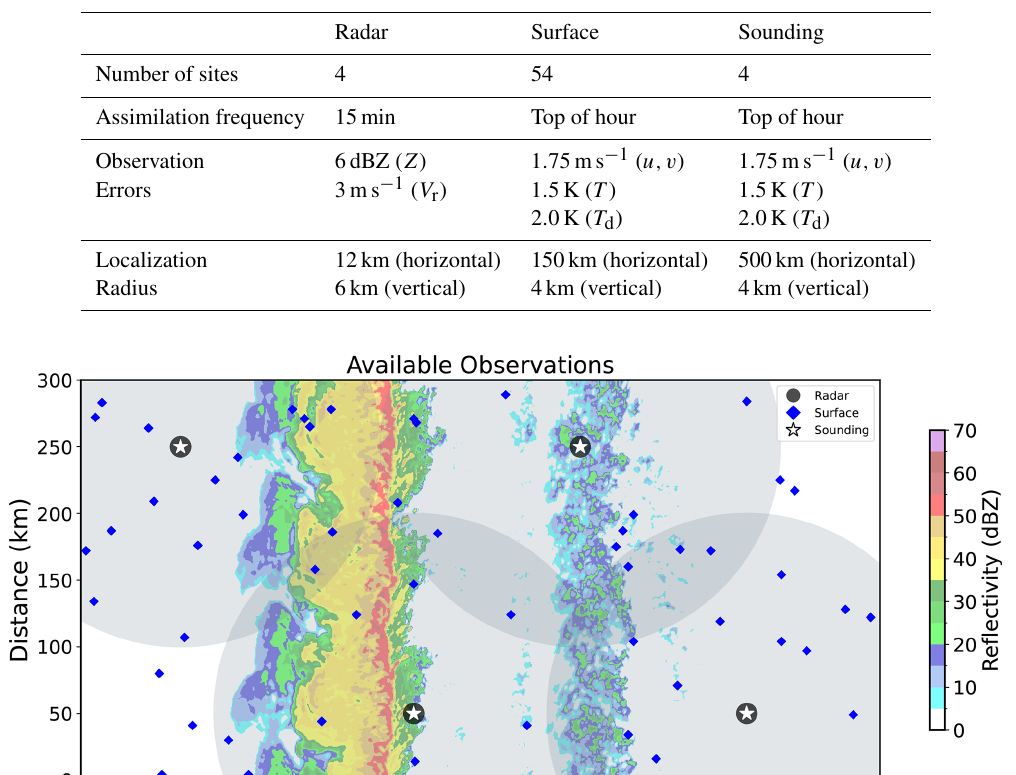
Table 2. The data assimilation parameters used for each observation type.